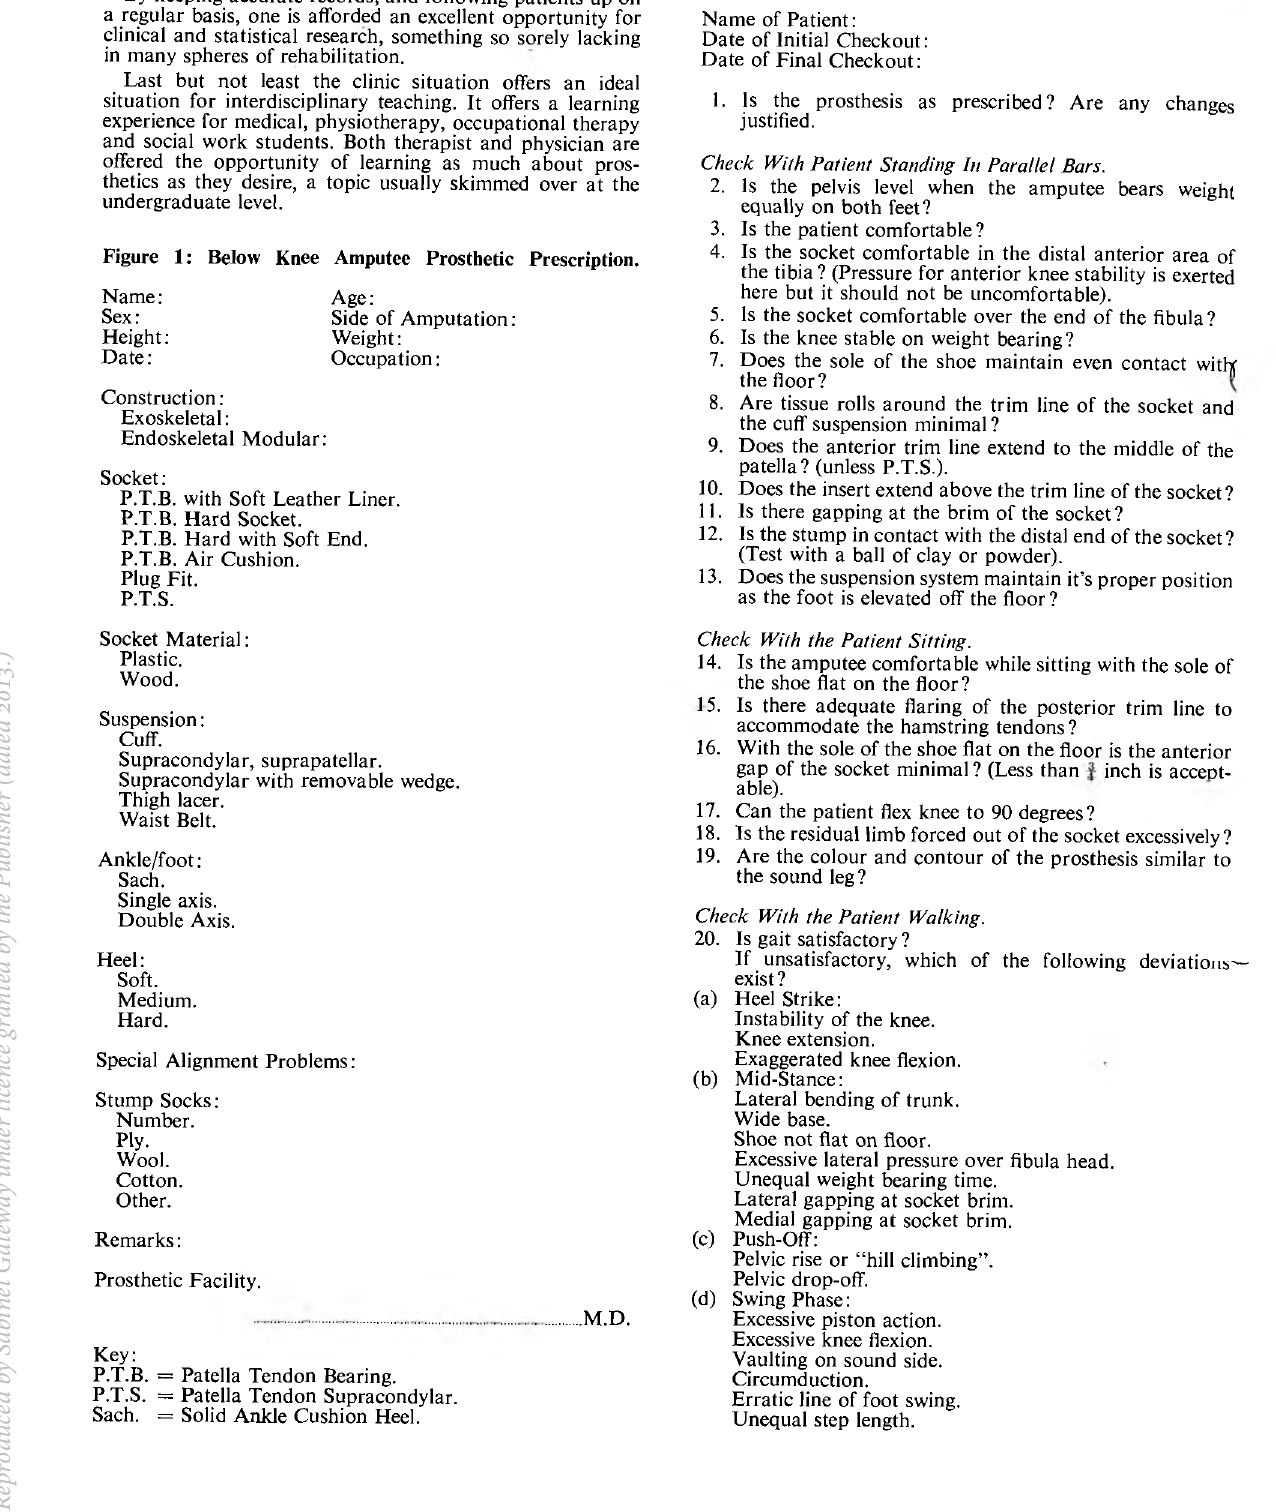
Figure 2: Checkout of Below Knee Prosthesis. Adapted from forms used at Northwestern University Chicago and University of California, Los